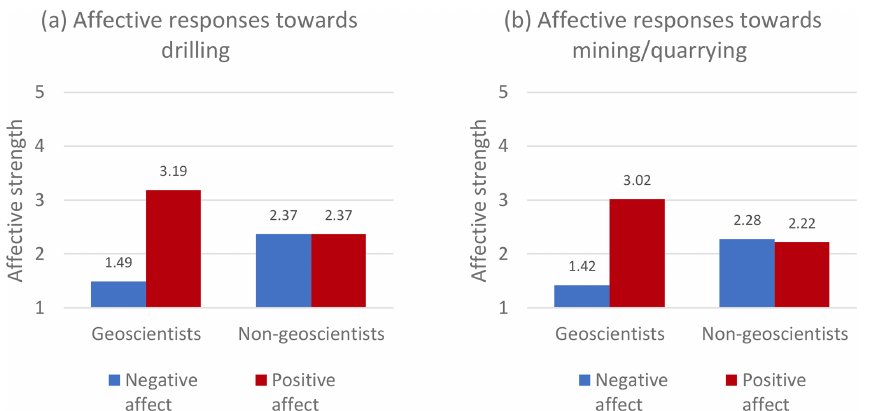
Figure 2. Affective responses towards drilling and mining/quarrying. Mean values of positive and negative affect responses are compared between geoscientists and non-geoscientists for different activities, namely (a) drilling and (b) mining/quarrying; measurements are on a scale from 1 (weak affective strength) to 5 (strong affective strength).